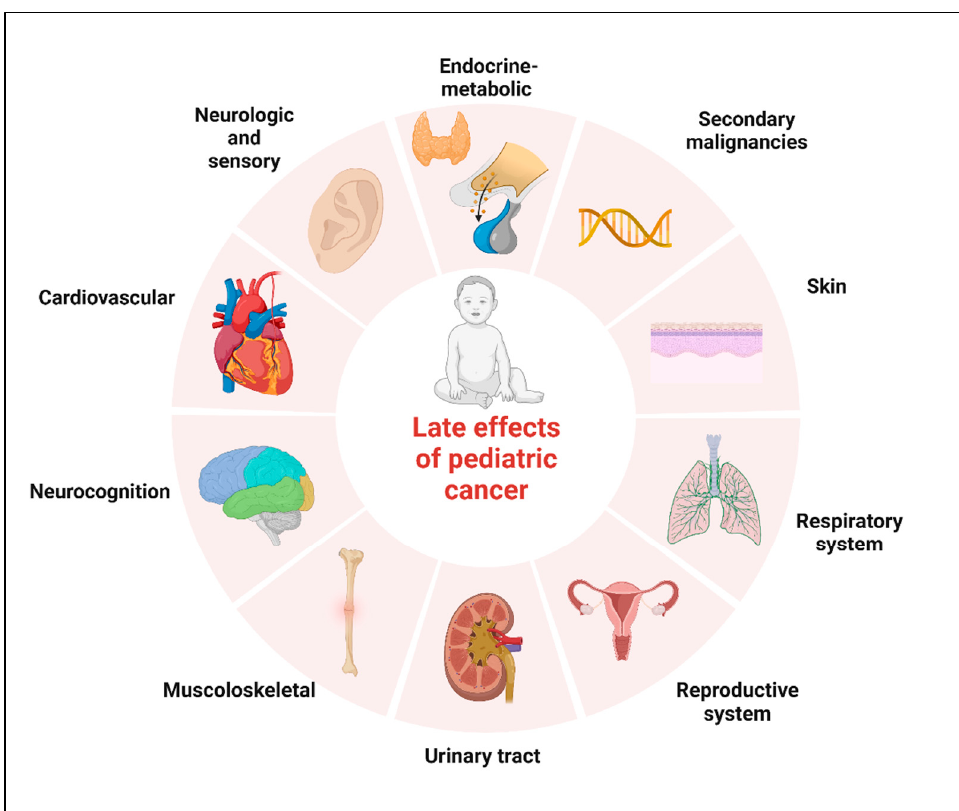
Figure 1. Potential complications of childhood cancer by organ system. Created with BioRen ‐ der.com.